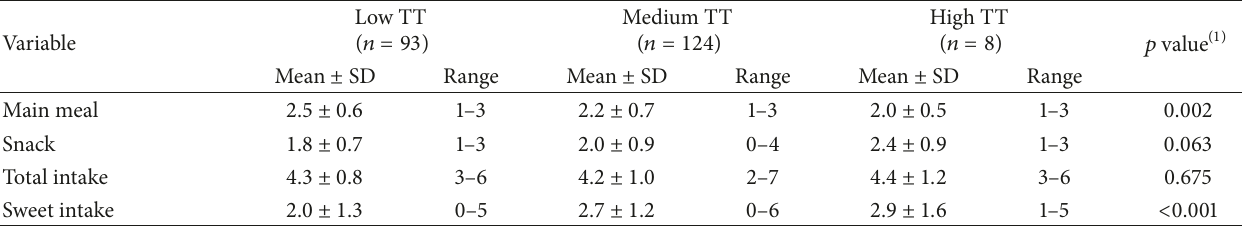
Table 2: Mean and standard deviation (SD) for main meal, snack, total intake, and sweet intake in Saudi schoolchildren according to TT (taste threshold) groups (low, medium, and high).